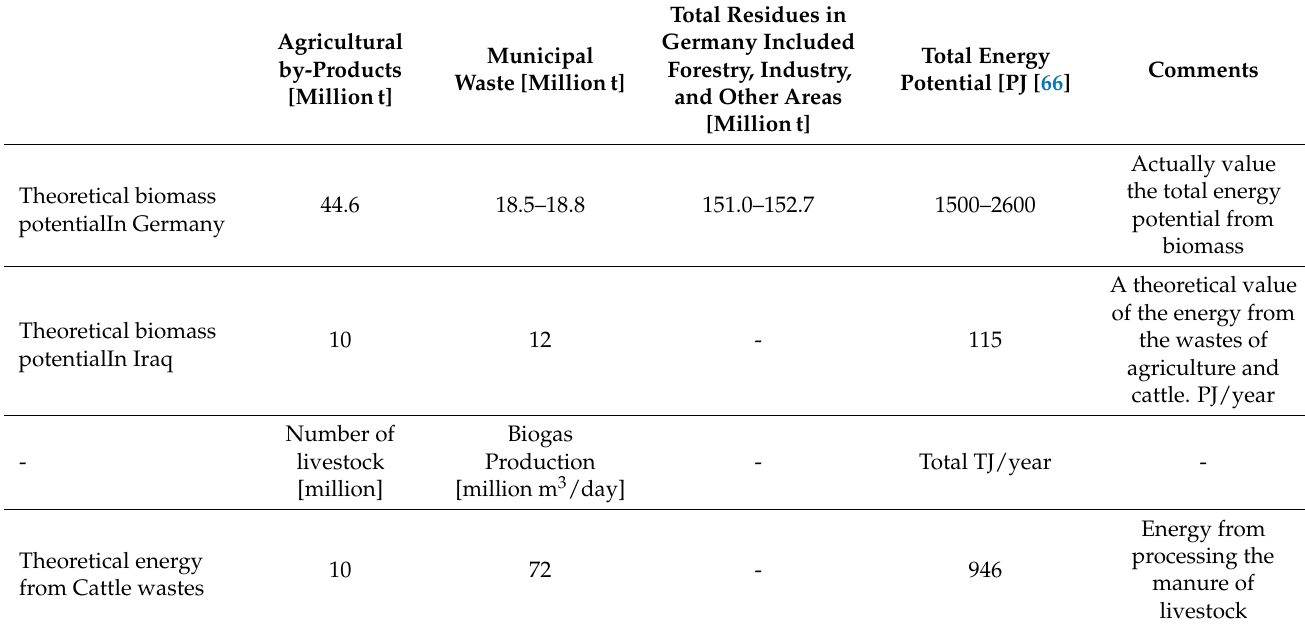
Table 9. Calculations of energy production from potential wastes studied in